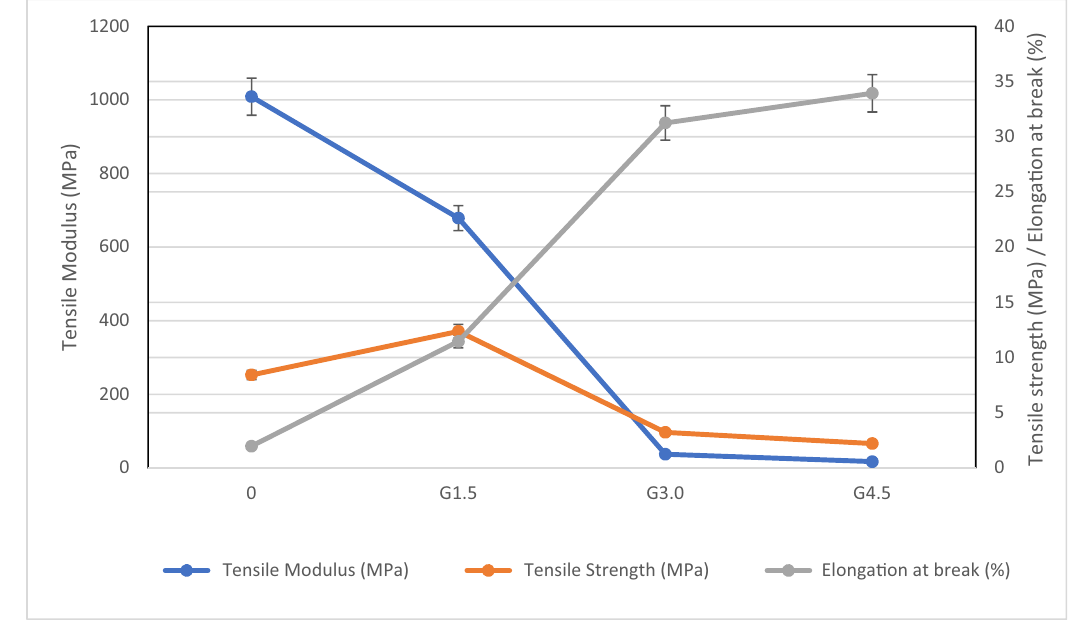
Figure 6: Mechanical properties of G - plasticized fi